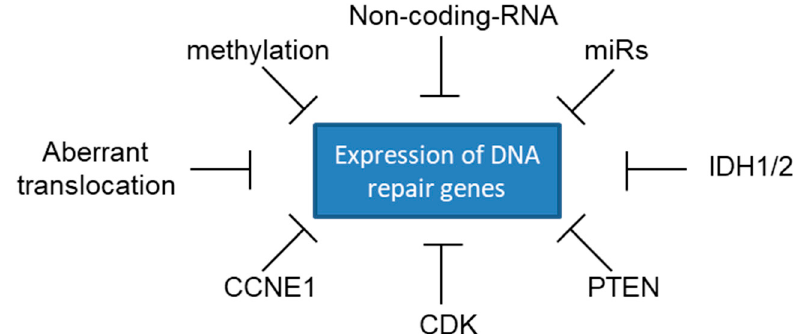
Figure 3. Molecular mechanisms that may cause reduced expression of DNA repair genes.